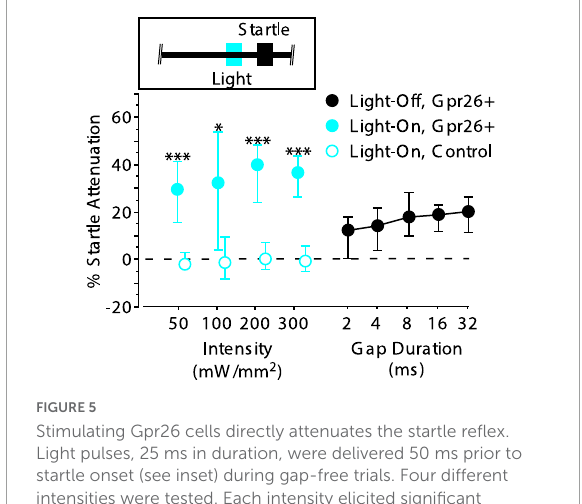
FIGURE5 Stimulating Gpr26 cells directly attenuates the startle reflex. Light pulses, 25 ms in duration, were delivered 50 ms prior to startle onset (see inset) during gap-free trials. Four different intensities were tested. Each intensity elicited significant attenuation of the startle reflex, with median attenuation at the lowest intensity exceeding that elicited by a 32 ms gap (for intensities 50, 100, 200, and 300 mW/mm 2 : n = 6 mice, 13, 16, 20, and 14 sessions, respectively). No attenuation was observed with illumination in control mice (for intensities 50, 100, 200, and 300 mW/mm 2 : n = 5 mice, 12, 15, 21, and 13 sessions, respectively). Boxes show median and IQR. ∗ p <